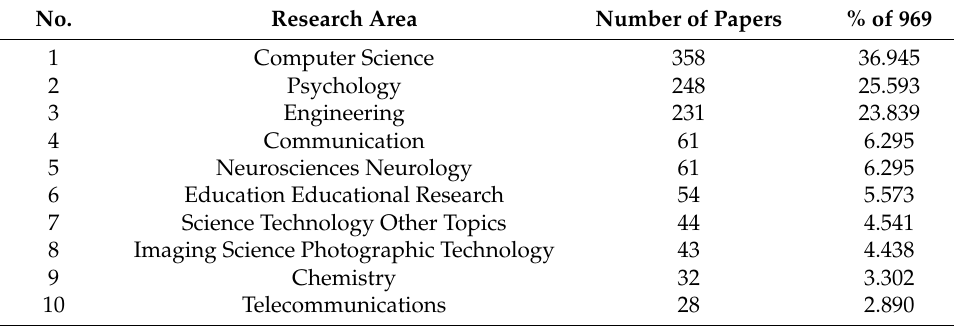
Figure 3. Most prolific research areas. Table 4. The top 10 most prolific research areas. Table 4. The top 10 most prolific research